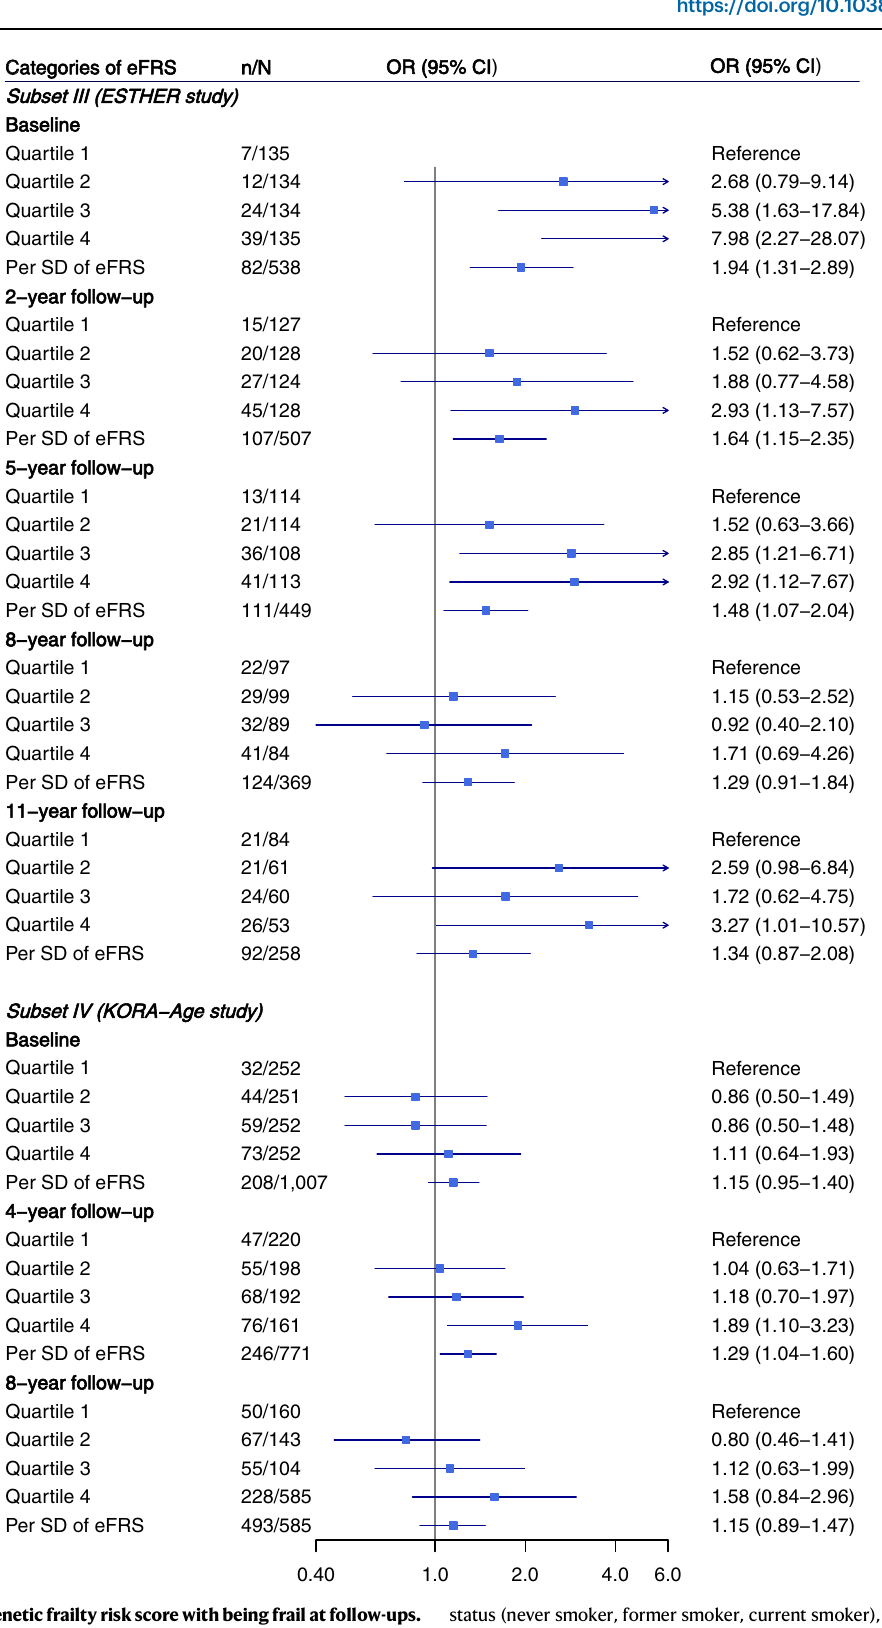
status (never smoker, former smoker, current smoker), and alcohol consumption (gperday).eFRSepigeneticfrailtyriskscore,ORoddsratio,CIcon fi denceinterval, SD standard